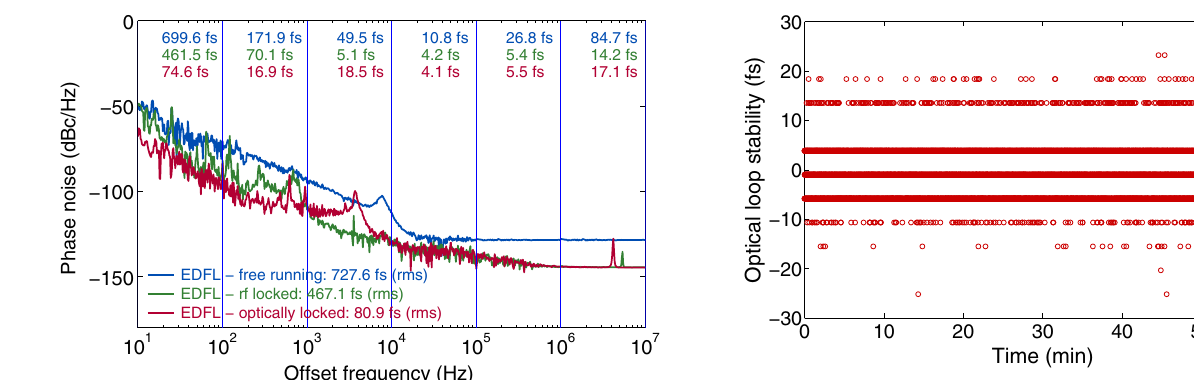
FIG. 37. Phase noise stability comparison between free running, rf-locked, and optically locked EDFL [109]. The values given in the upper part of the figure refer to rms jitters measured in the respective frequency ranges. The values in the lower part of the figure are jitters measured over the entire frequency range (10 Hz to 10 MHz).